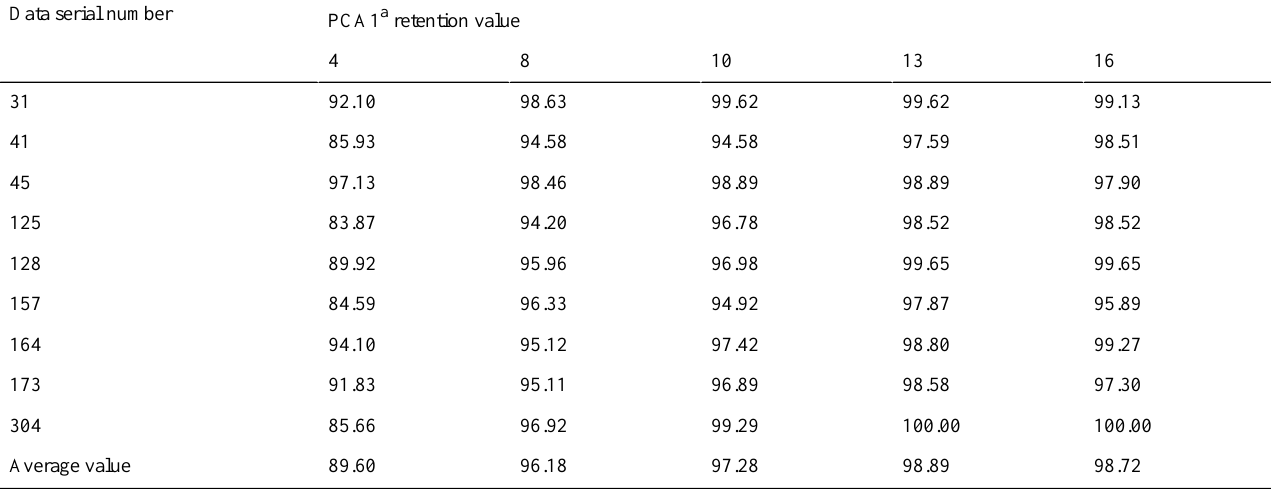
Table 1. Classification accuracy of the first layer of Letter data with different PCA1 retention values (%).